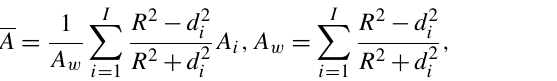
A total of 45 kinds of aerosols components, including sulfate, ammonium, black carbon, organic carbon, and sea salt, have been considered in this